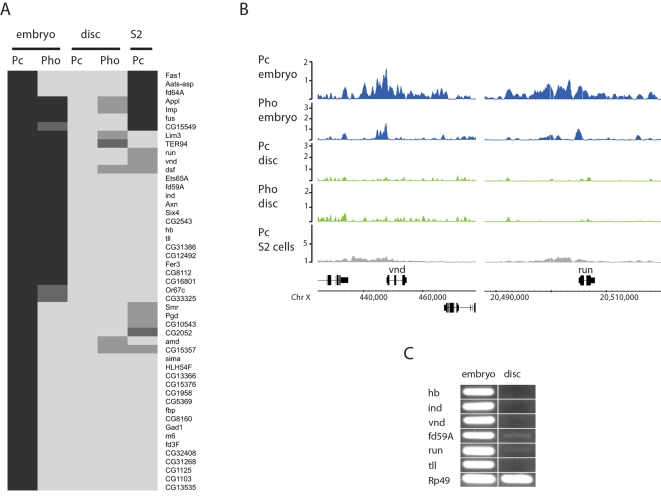
Pc targets bound in the embryo but not in T3 imaginal discs.(A) Cluster diagram showing binding classification for the 49 genes positive for Pc binding in embryo but not in T3 discs. Black: positive peak overlapping transcription unit; dark grey: positive peak closer to this gene than any other gene; mid grey: intermediate peak overlapping transcription unit; pale: negative. The Pho binding follows the Pc binding and the 49 genes are also generally negative for Pc binding in S2 cells. (B) Example binding profiles for genes in this class showing vnd and run. (C) RT-PCR analysis on selected genes shows expression in embryos but little or no expression in T3 discs. Rp49 provides a positive control.